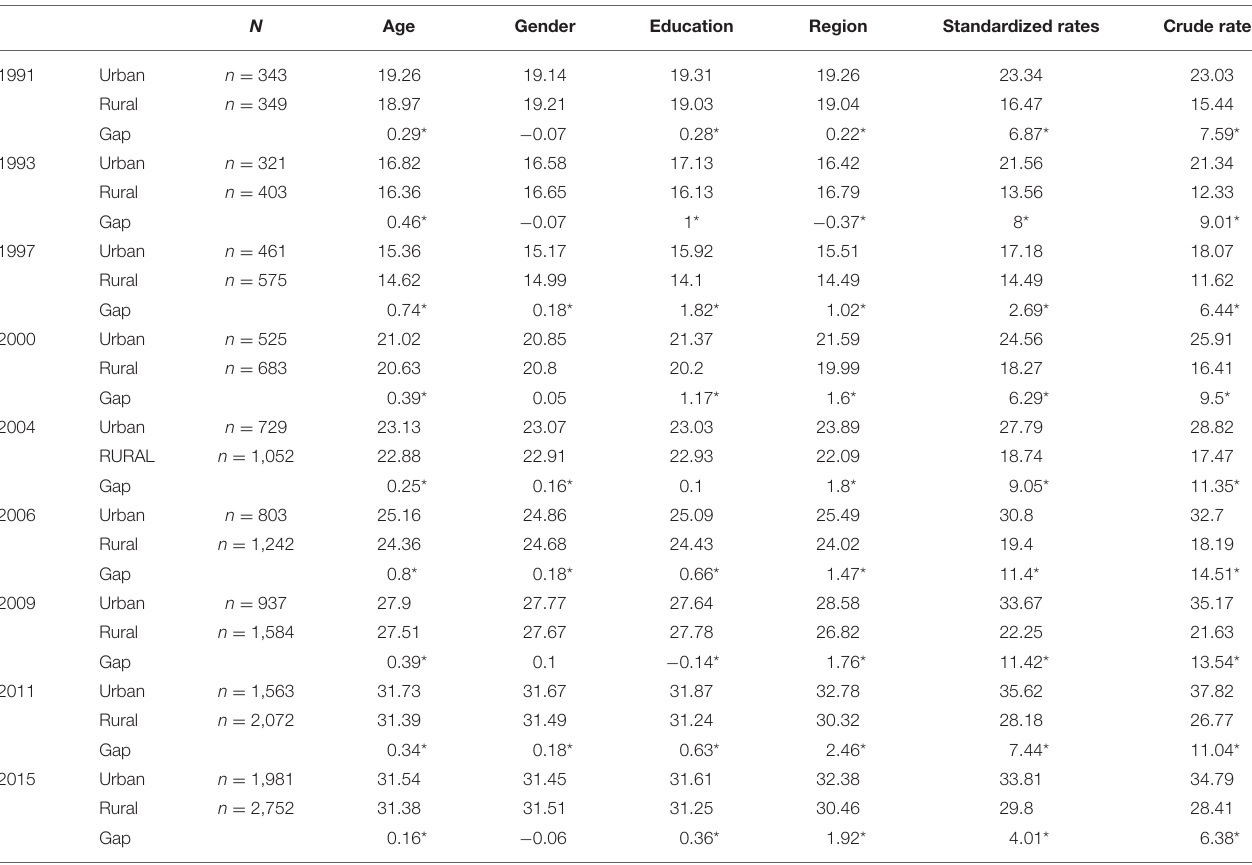
TABLE 1 | Results of standardization HTN rates (%) and gaps between urban and rural areas of the older adults by demographic and social development factors, 1991–2015. N Age Gender Education Region Standardized rates Crude rates